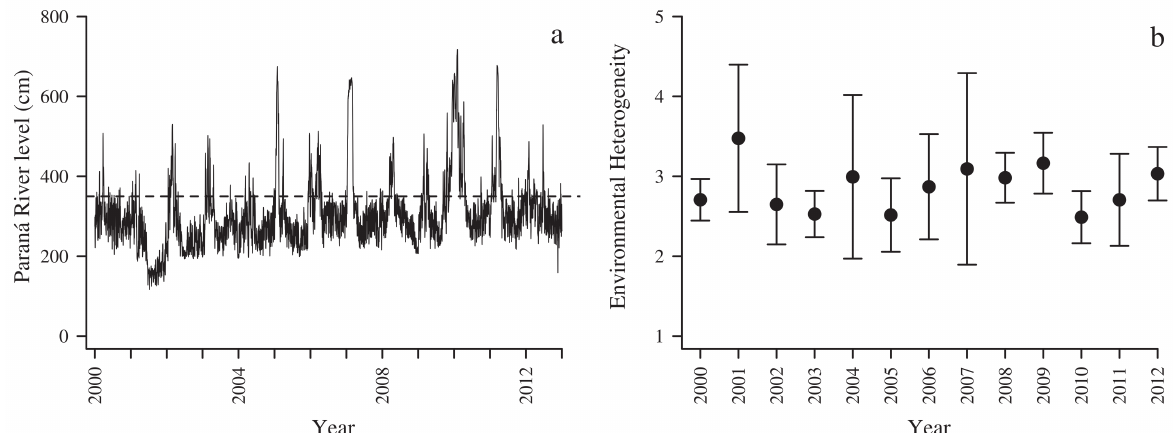
Fig. 2. Hydrometric-level (a) and environmental heterogeneity (b) variation between 2000 and 2012 in the Paraná River. The horizontal black dashed line indicates the flood level of the floodplain. Source: ANA - Estação Fluviométrica of Porto São